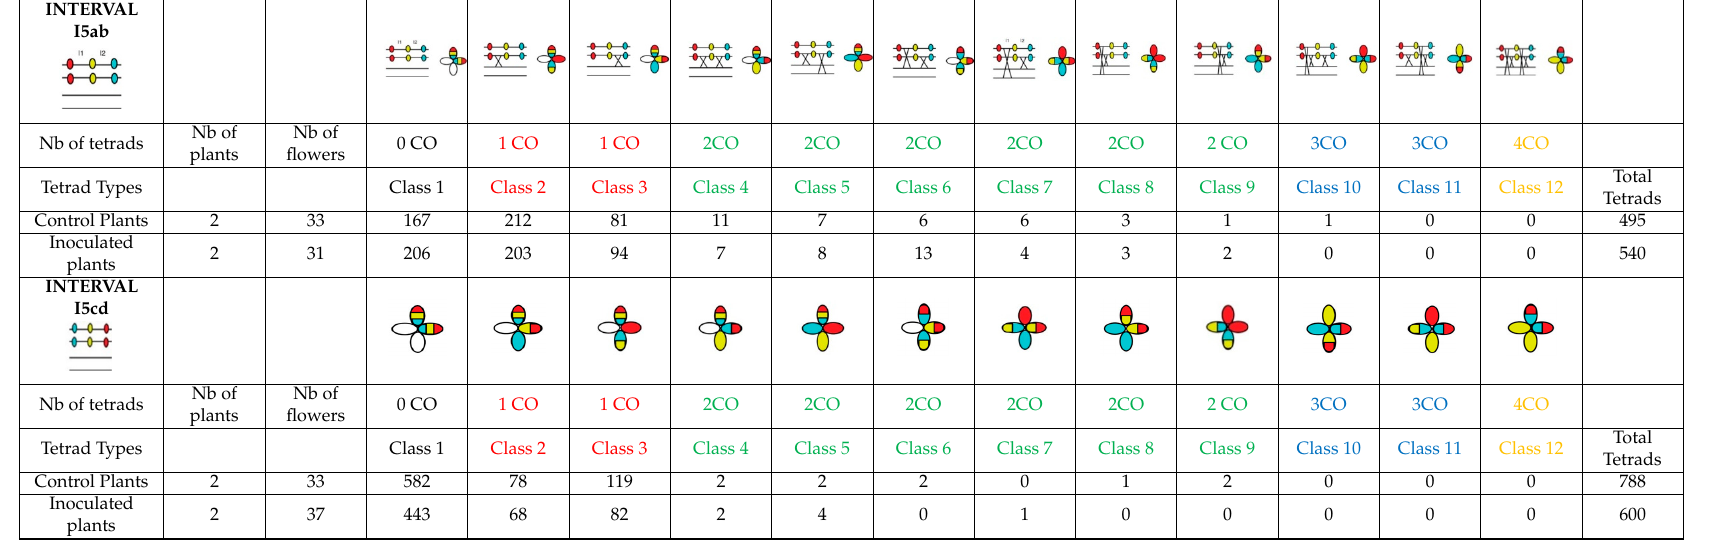
Table 1. Classification and counting of pollen tetrads in control and inoculated plants of I5ab and I5cd lines. For each FTL line containing the three markers (cyan, red and blue), the different possibilities of markers distribution among the four chromatids and the corresponding distribution in the tetrad have been represented as drawings above each column, according to Berchowitz and Copenhaver’s nomenclature [30]. For each condition (control or inoculated), since a similar pattern of tetrad distribution was observed for the two plants studied, revealing no bias related to a single plant, the observed total number of each type of tetrad is given for the two plants corresponding, either to the interval I5ab (up) or to I5cd (down). Similarly, the total number of flowers and tetrads from the two control and the two inoculated plants analyzed in this study are also mentioned for both I5ab and I5cd lines.